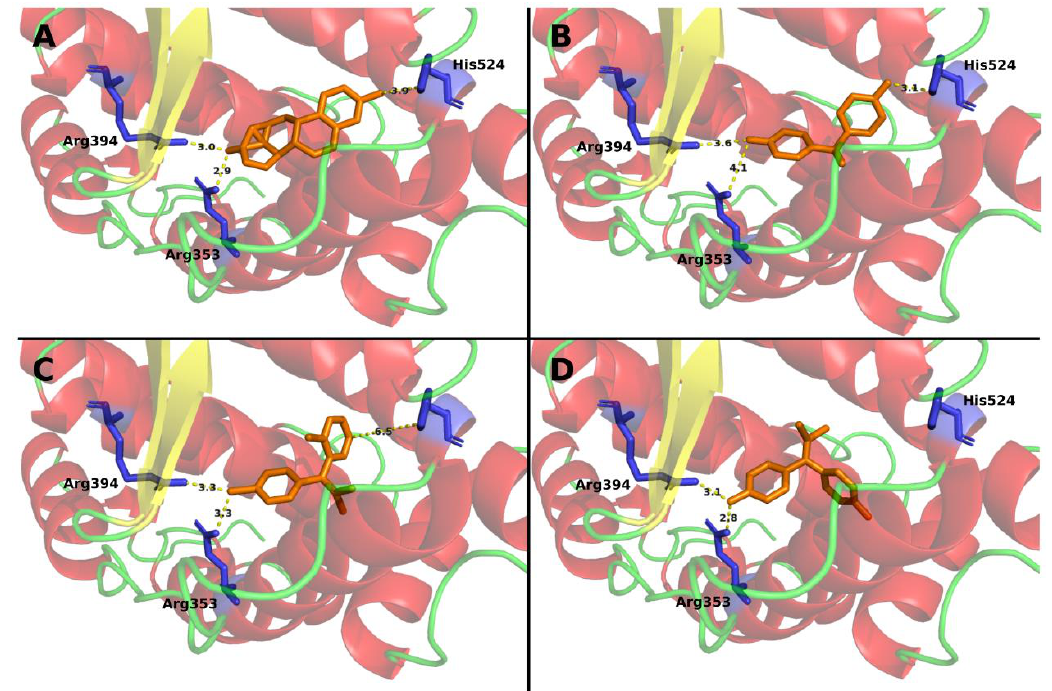
Figure 1. Docking of the different compounds in the binding pocket of ER-α. The predicted placement of ligand within the binding pocket of ER-α was predicted using SwissDock for E2 ( A ), BPA ( B ), mitotane ( C ), and BPC ( D ). Ligand is represented in orange and the three main residues involved in ligand interactions are marked in the structure in blue. When arranged in the binding pocket, the 2 agonist compounds, namely, E2 and BPA are placed within reasonable distance from the interacting residues, while the antagonist BPC assumes a different conformation, losing interaction with His524. Interestingly, mitotane seems to behave similarly to agonist compounds.